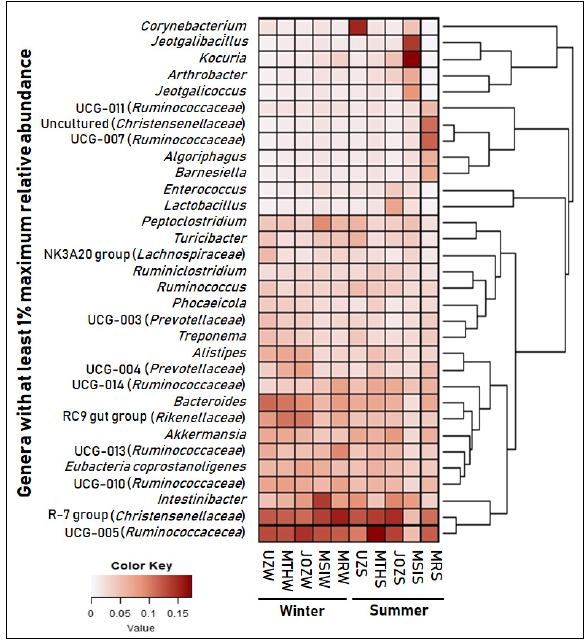
Figure 5: Heat map showing genera with at least 1% maximum relative abundance in at least one sample. Cluster dendrogram is based on average linkage hierarchical clustering of the Bray–Curtis distances of operational taxonomic units at genus taxa level. Average abundance value of the duplicate sample libraries was used. Family taxonomic classification is provided in parenthesis where genus taxonomic names are potentially ambiguous.